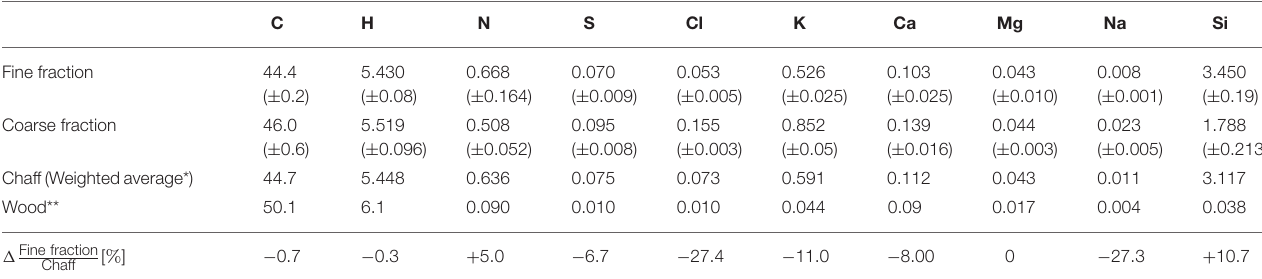
TABLE 1 | Elemental composition of chaff fractions after sieving in %(w/w) on a dry basis (averaged values with standard deviation). C H